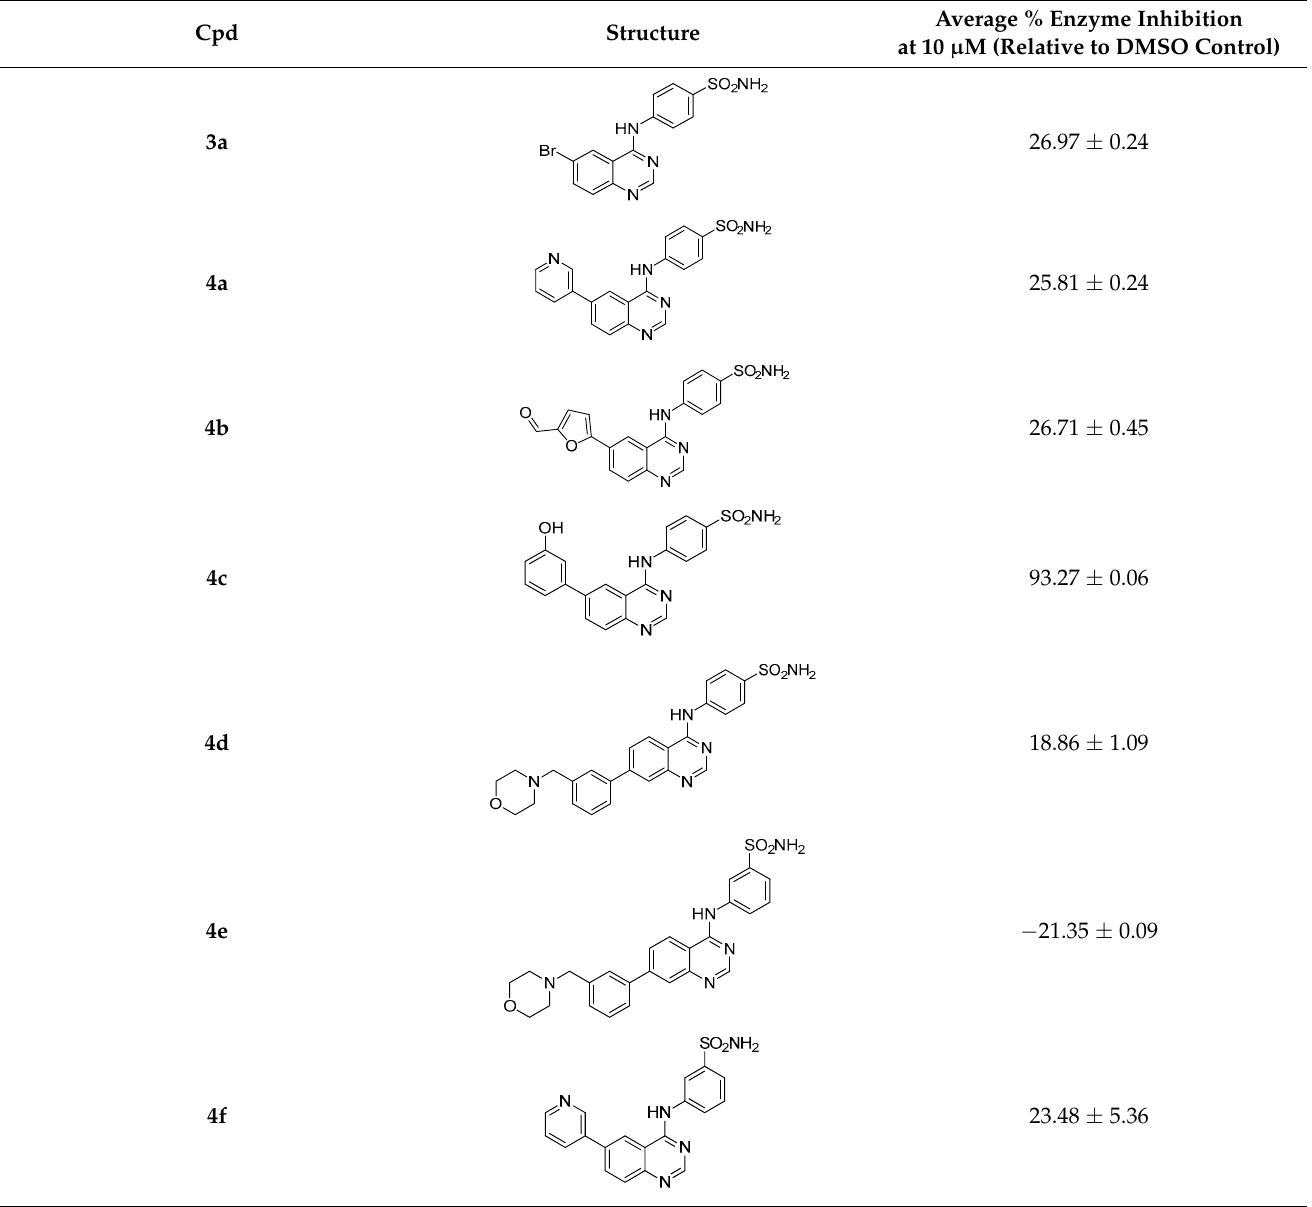
Table 4. % Inhibition values of the synthesized compounds 3a and 4a – f over EphB3 kinase at 10 µM concentration. Cpd